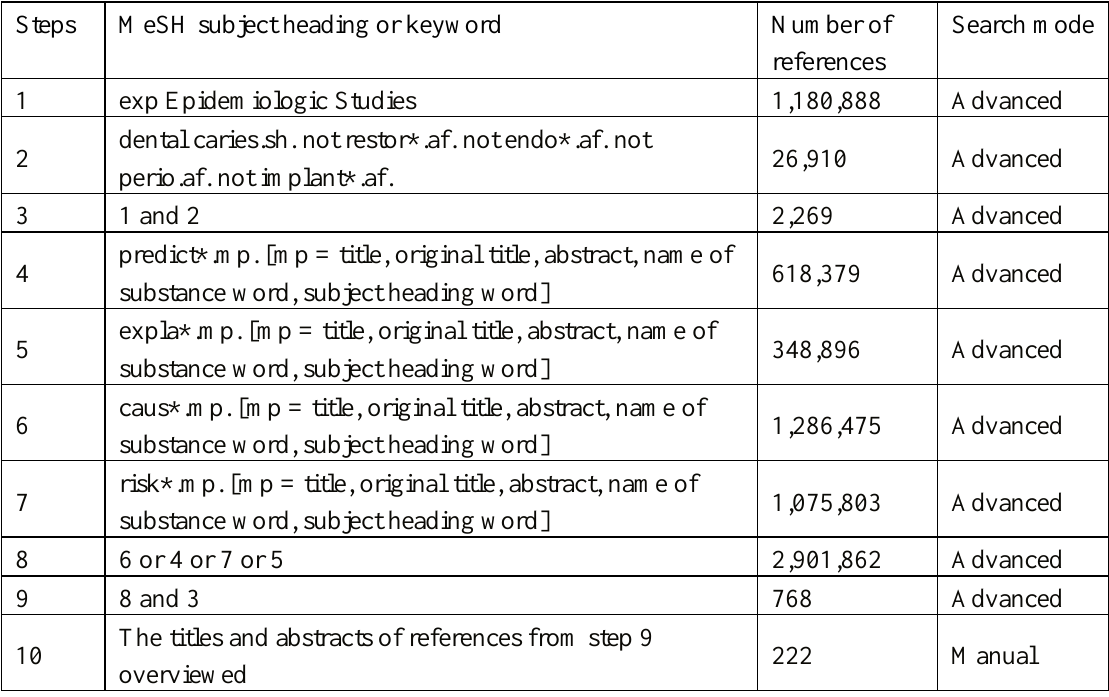
Table 1. The MEDLINE (1950 to Present with daily update) database search for dental caries risk studies in